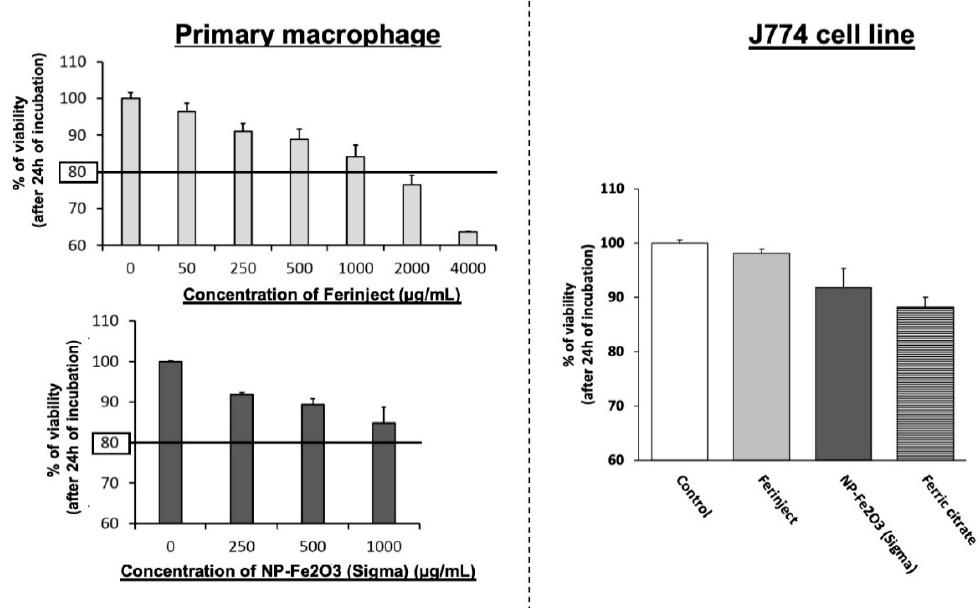
Figure 2. Viability of macrophages. Left graphic: primary mouse macrophages were exposed for 24 h to increasing exposure concentration of FERINJECT ® or Fe 2 O 3 -NP Sigma in order to determining LD20. Right graphic: J774A.1 cells lines were incubated with 1 mg/mL of these nanoparticles or equivalent Ferric citrate. Viability was measured using propidium iodide (1 μ g/mL).